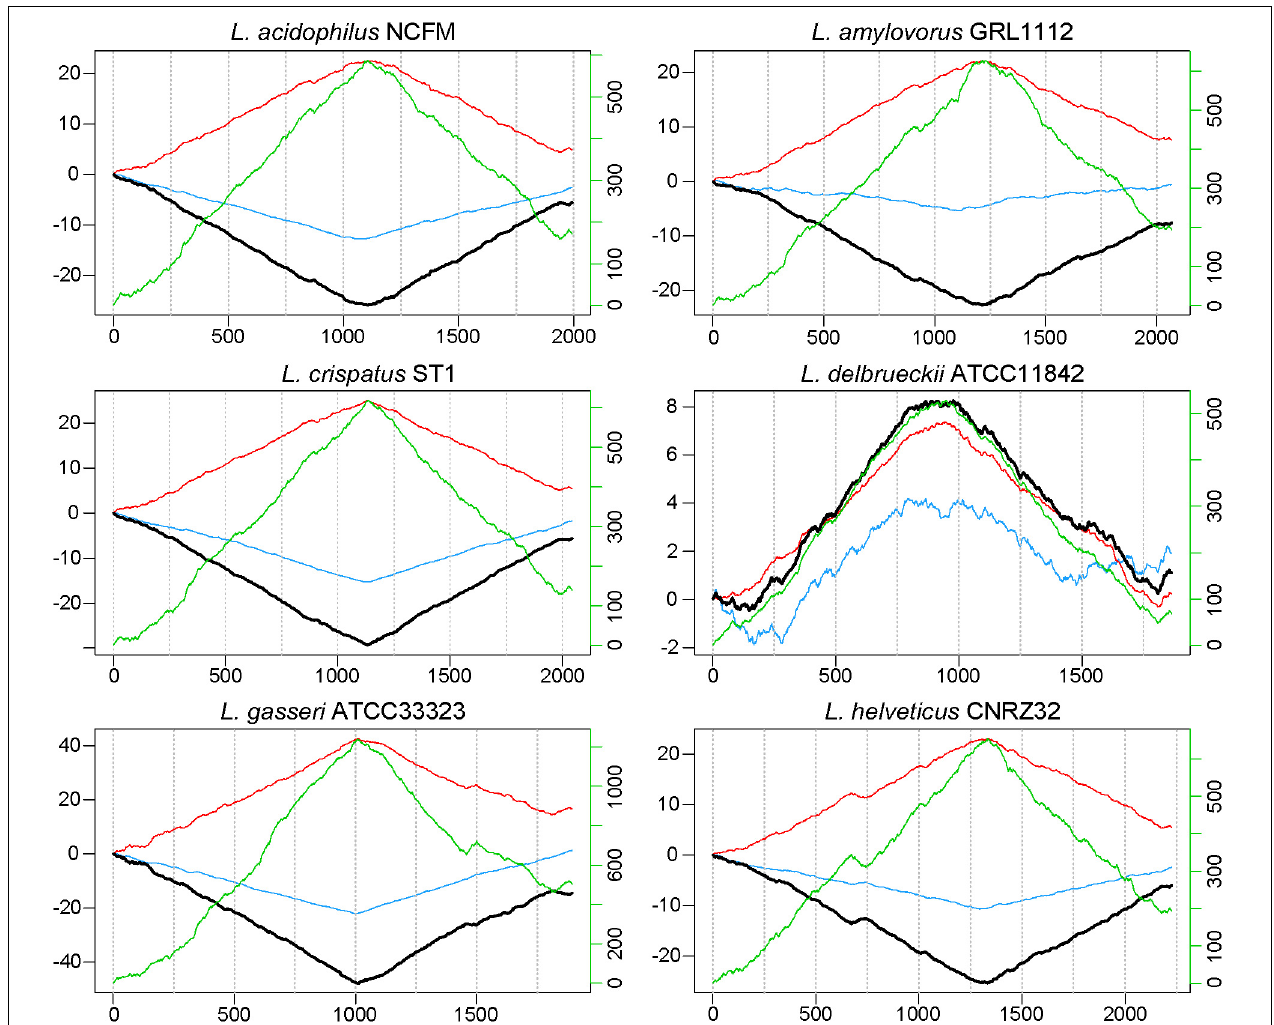
FIGURE 1 | GC, TA and coding sequence skew in L. acidophilus complex. The cumulative skew for TA frequency (red line), GC frequency (blue line), and coding sequence density (green line) are used to predict the location of the terminus and origin (black line). The absolute minimum or maximum is predicted to be the terminus. The location in each genome (in kilobases) is displayed along the horizontal axis. The left y -axis shows cumulated combined skew in kb; the right y -axis shows cumulated coding sequence density